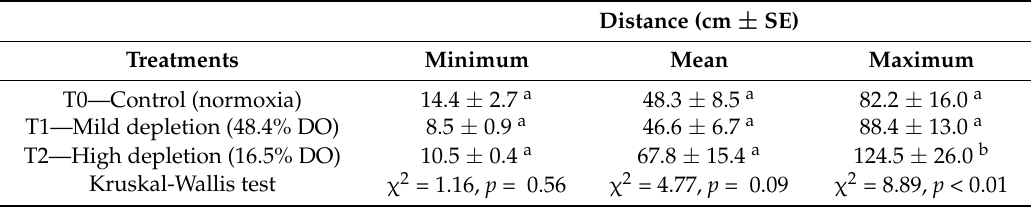
Table 2. Average minimum, mean, and maximum distances (cm ± SE) between fish within a shoal during the three